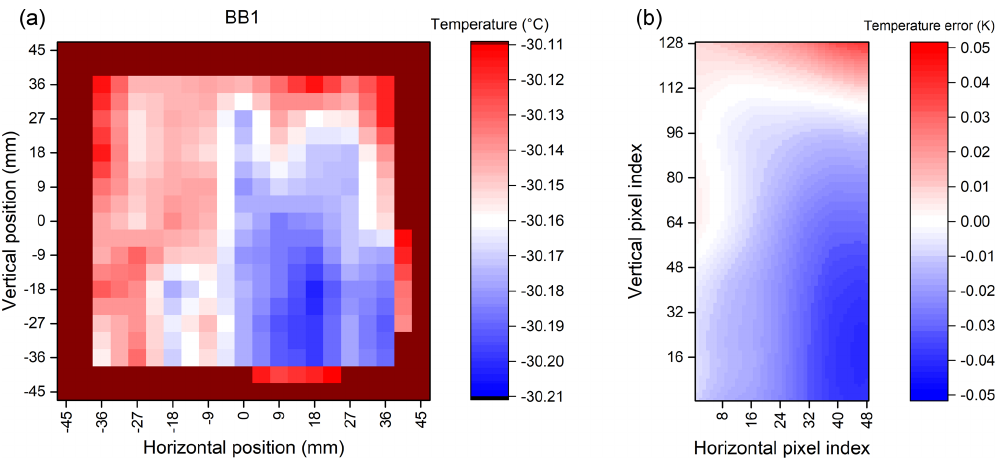
Figure 8. Measured surface radiance temperatures at − 30.15 ◦ C (243K) for BB1 (a) and estimated resulting temperature error for each of the 48 × 128 detector pixels (b)